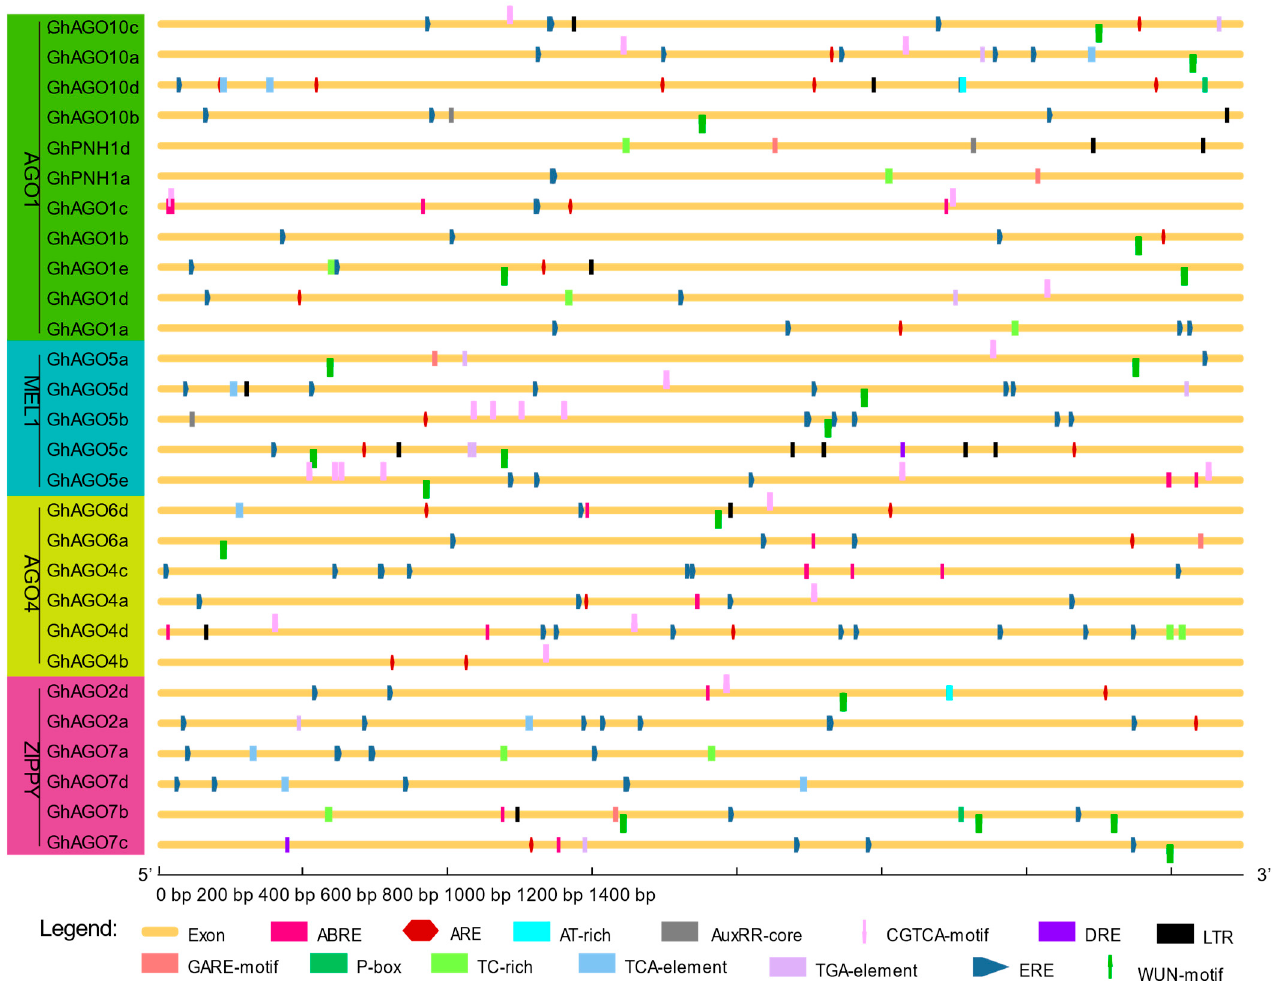
Figure 5. Analysis of cis-acting regulatory elements of the GhAGO genes. The yellow lines represent the promoter regions of the GhAGO genes. The scale bar at the bottom denotes the length of the promoter sequence.